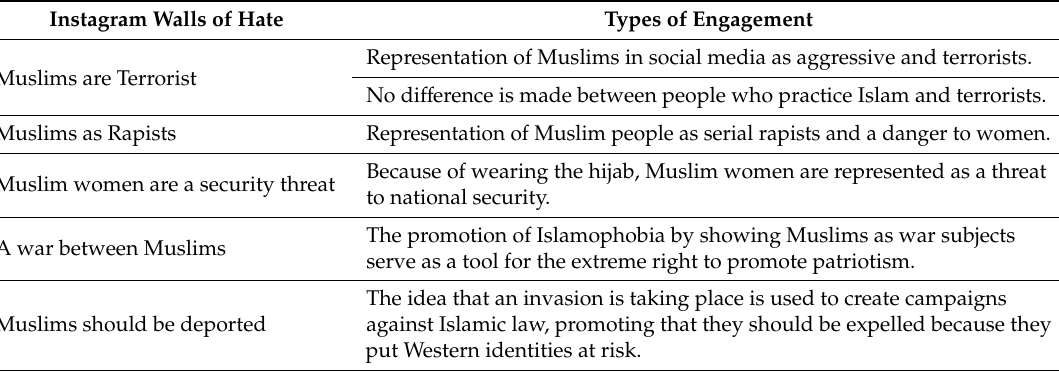
Table 2. Five walls of Islamophobic